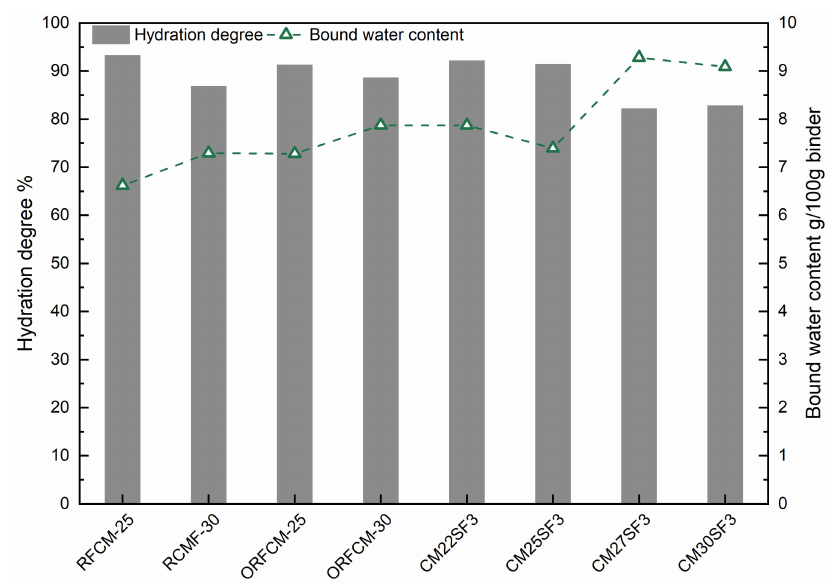
Figure 12. Hydration degree and bound water content of all the samples at 90 d.